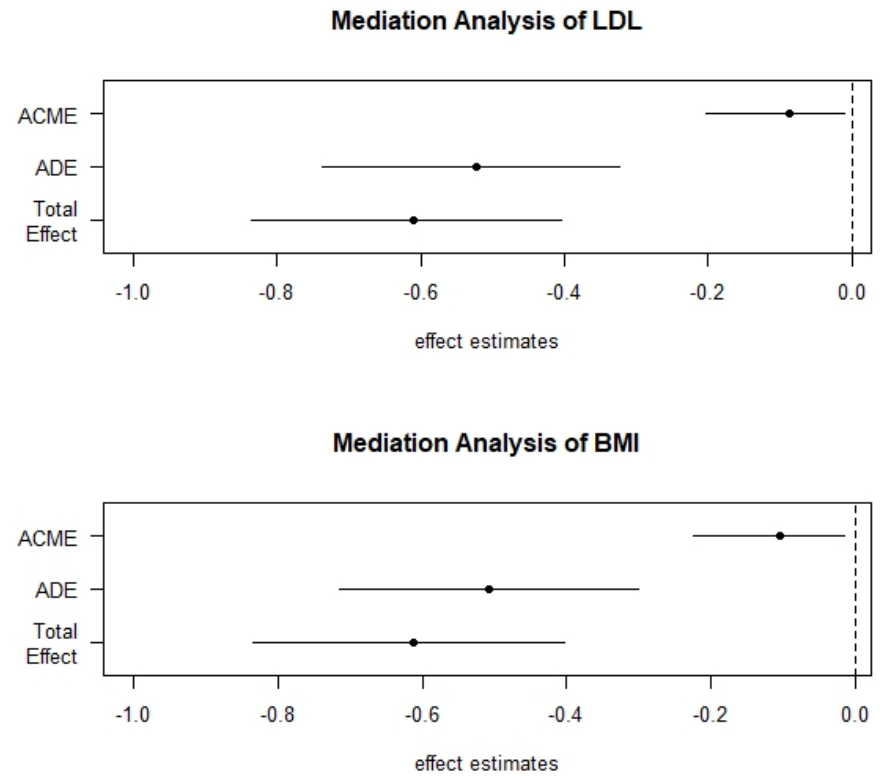
Figure 6. quantile–quantile plots of the variables that showed partial mediation.